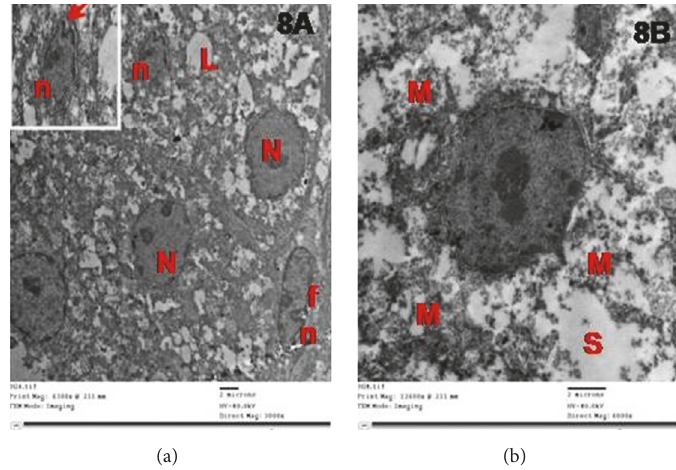
Figure 8: Electron micrographs of the adrenal cortex in group II showing that ZG cells with (a) nuclei (N) have irregular outlines and few lipid droplets (L). Notice the shrunken nucleus (n) with widened perinuclear space (arrow in inset). Notice the fibroblast of the capsule with elongated nucleus (fn). (b) Degenerated mitochondria with disrupted cristae (M) and dilated cisternae of SER (s).